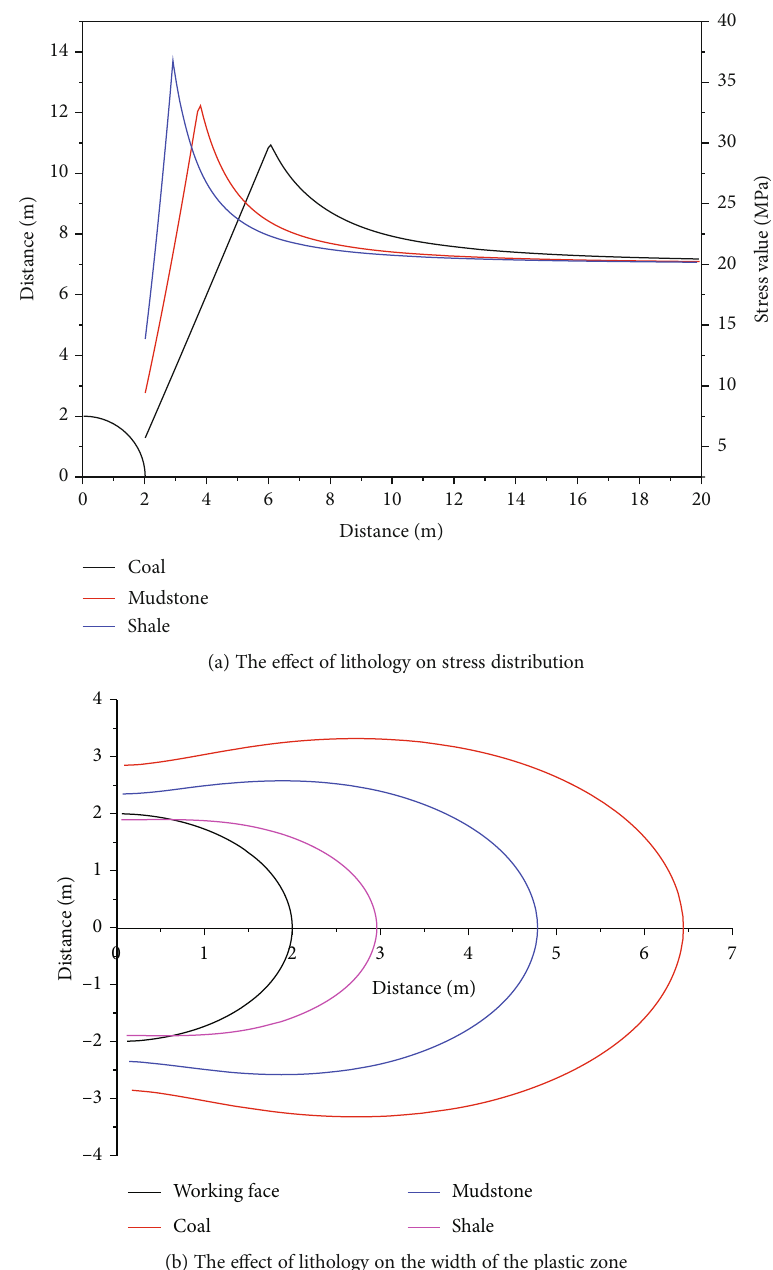
Figure 2: Relationship between lithology and original